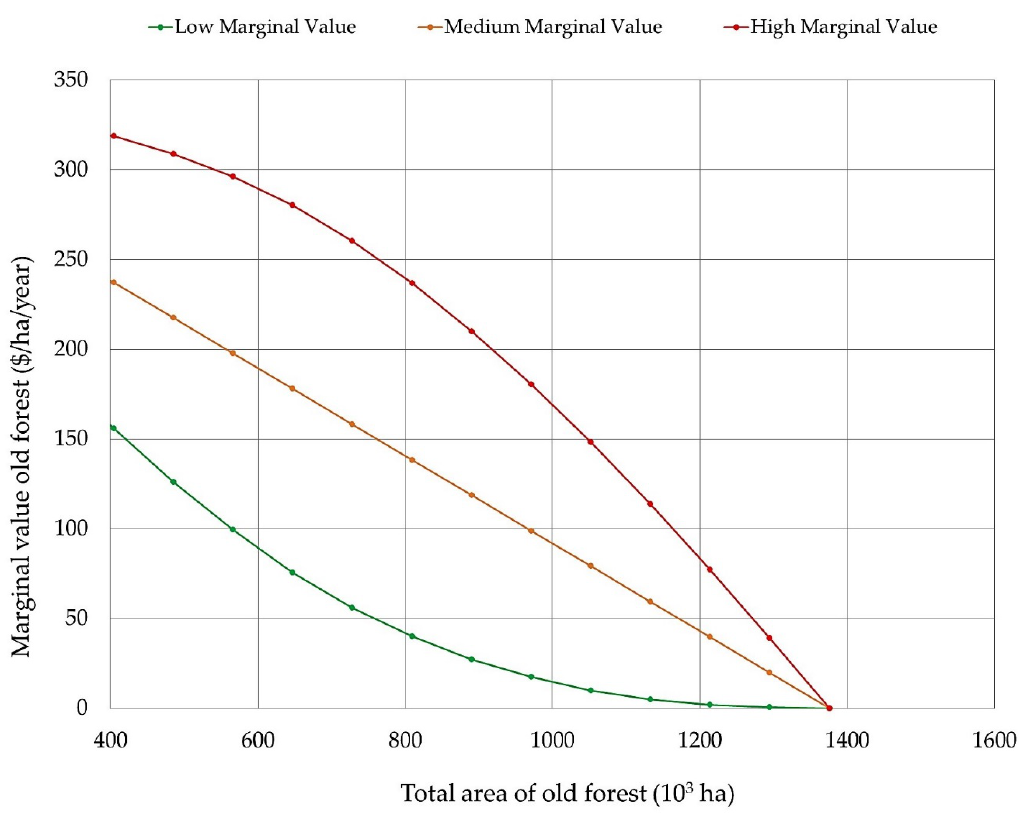
Figure 4. Downward–sloping marginal value functions used for the old forest as the ecosystem service.